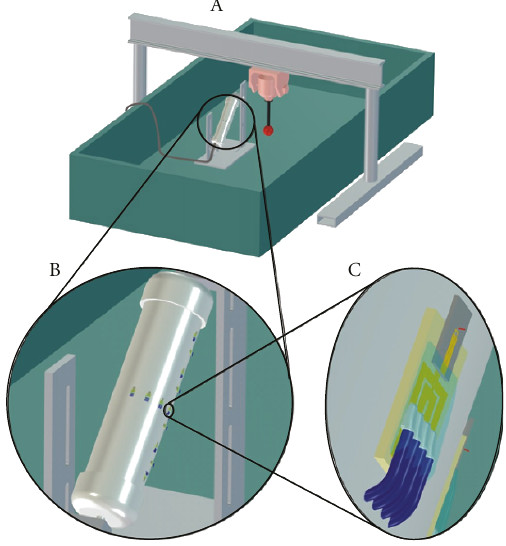
Figure 3: Experiment setup with the sensor arrays installed on a cylinder. A shaking machine controls the vibration of an dipole. The cylinder can be slid on a vertical frame to change relative vibration direction of the dipole to the